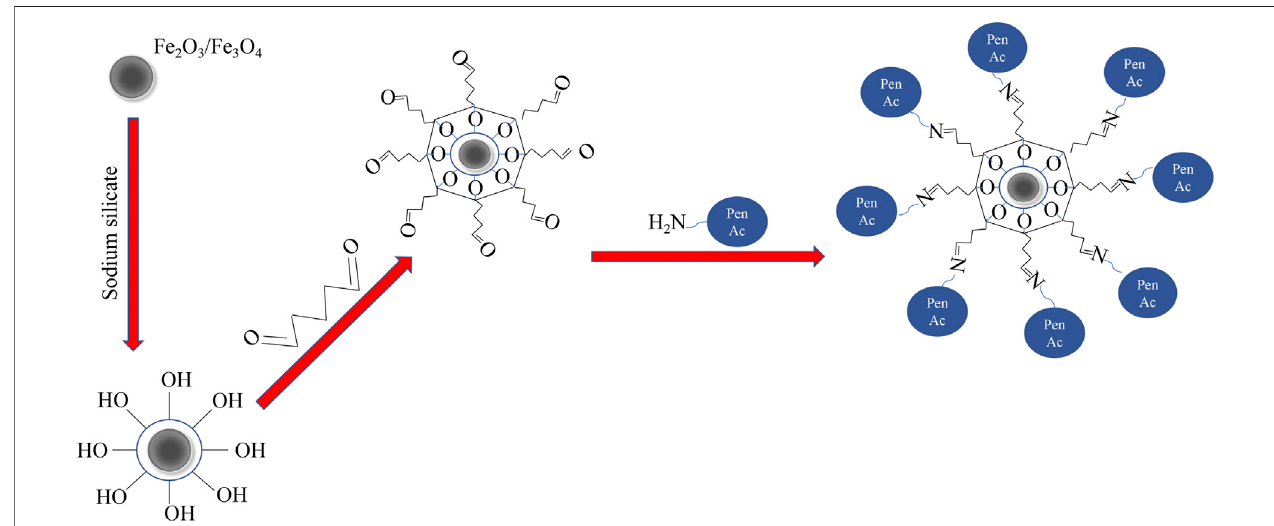
FIGURE 1 | The process of penicillin G acylase (PGA) immobilized onto α -Fe 2 O 3 /Fe 3 O 4 heterogeneous nanosheets.